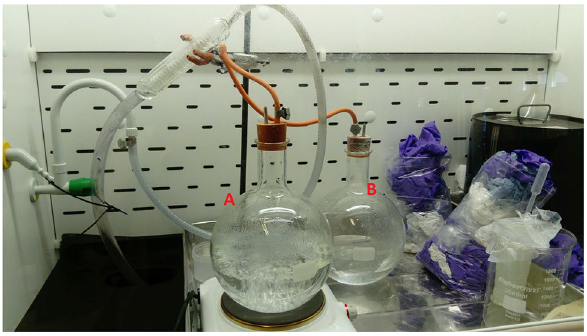
Fig. 2 Photograph of the enclosed system during a boil, showing the flask undergoing volume-reduction, flask A, and the flask with the condensed liquid, flask